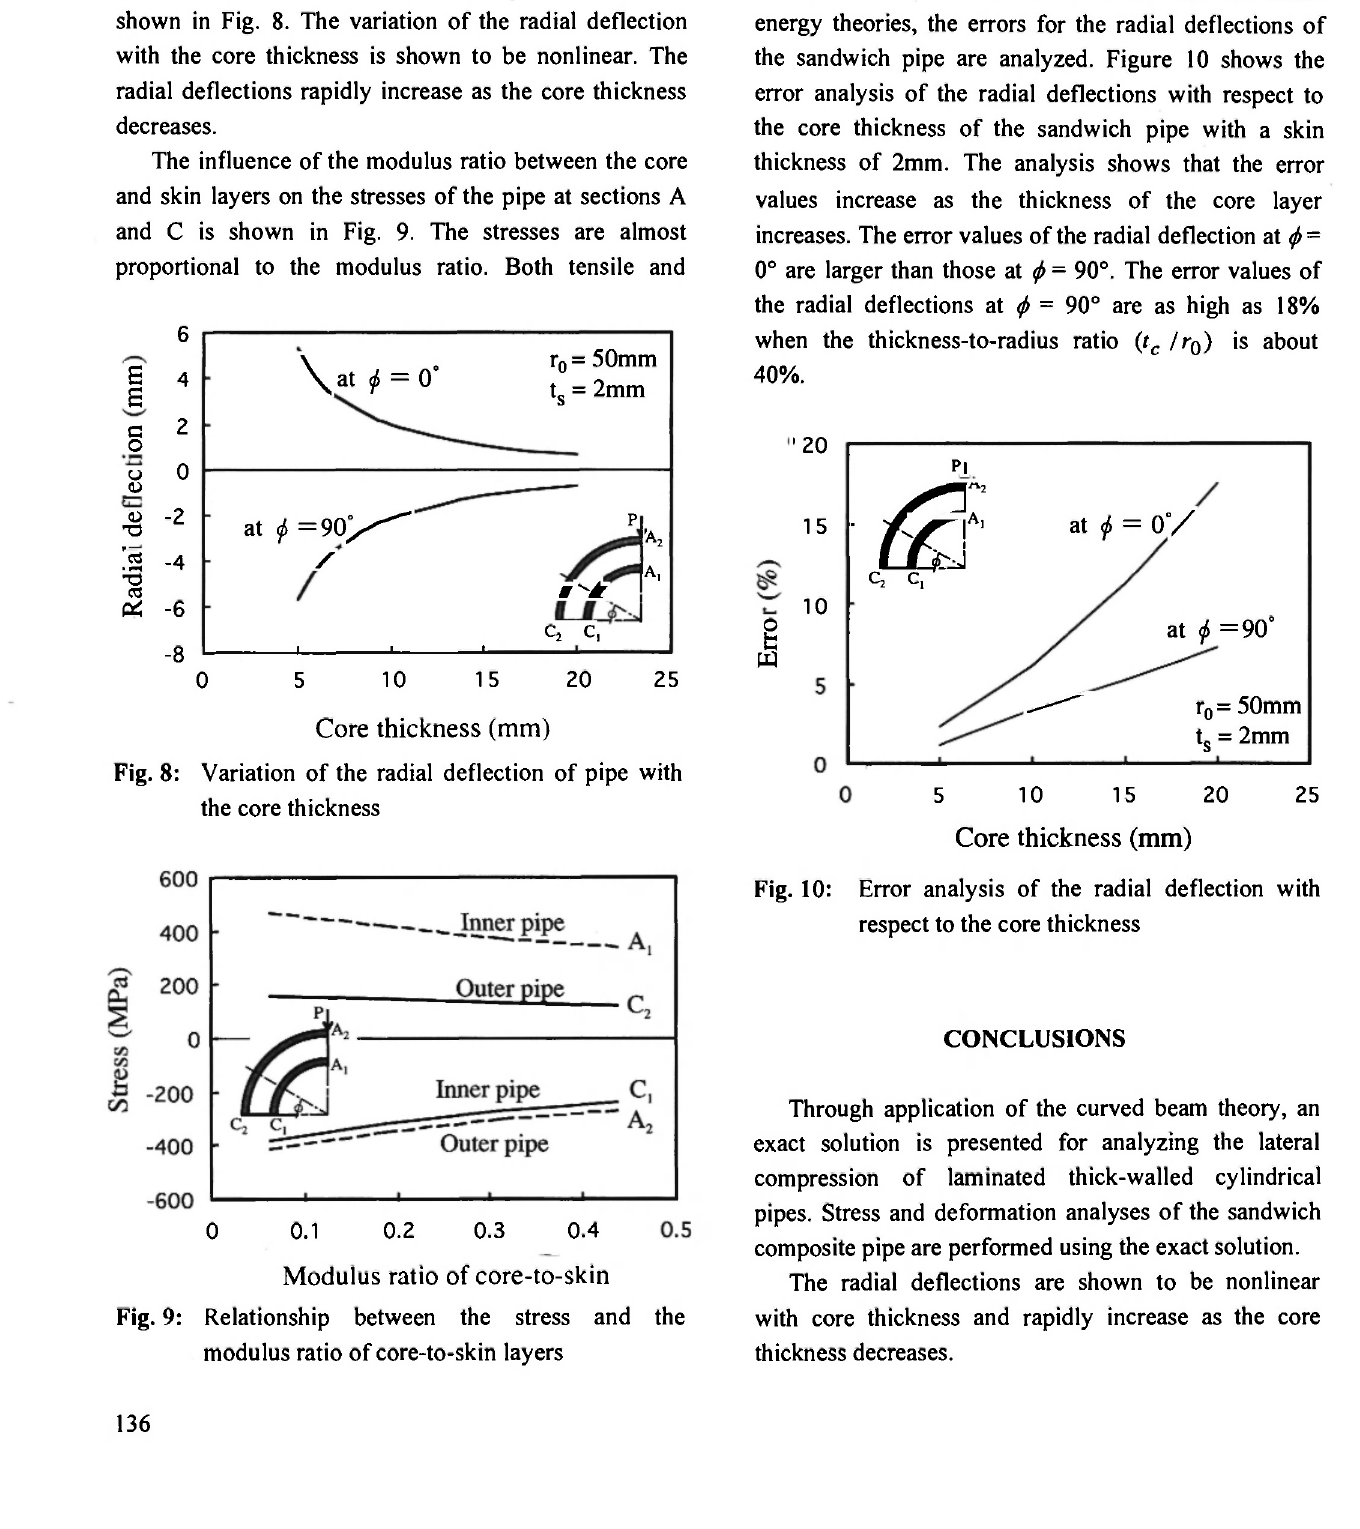
Fig. 9: Relationship between the stress and the modulus ratio of core-to-skin layers